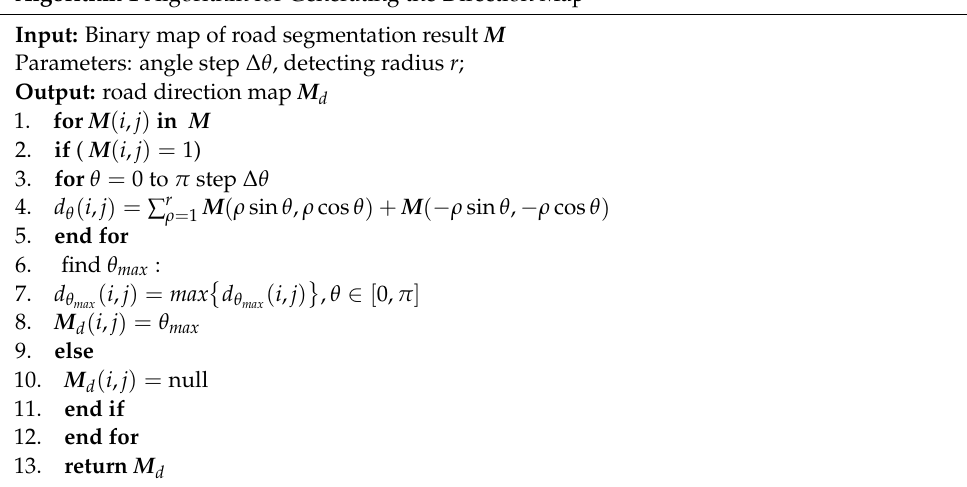
Algorithm 1 Algorithm for Generating the Direction